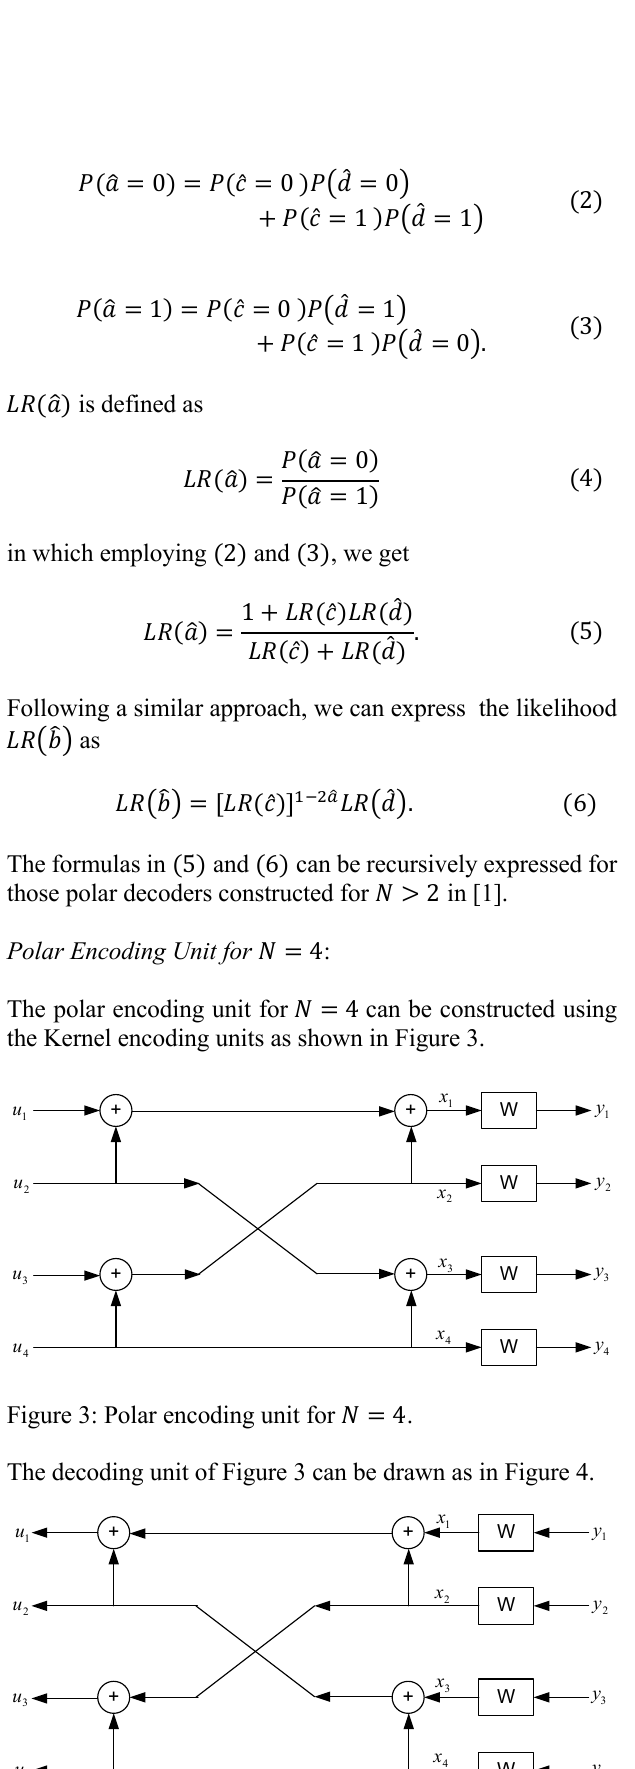
Figure 6 Decoding path of 𝑢